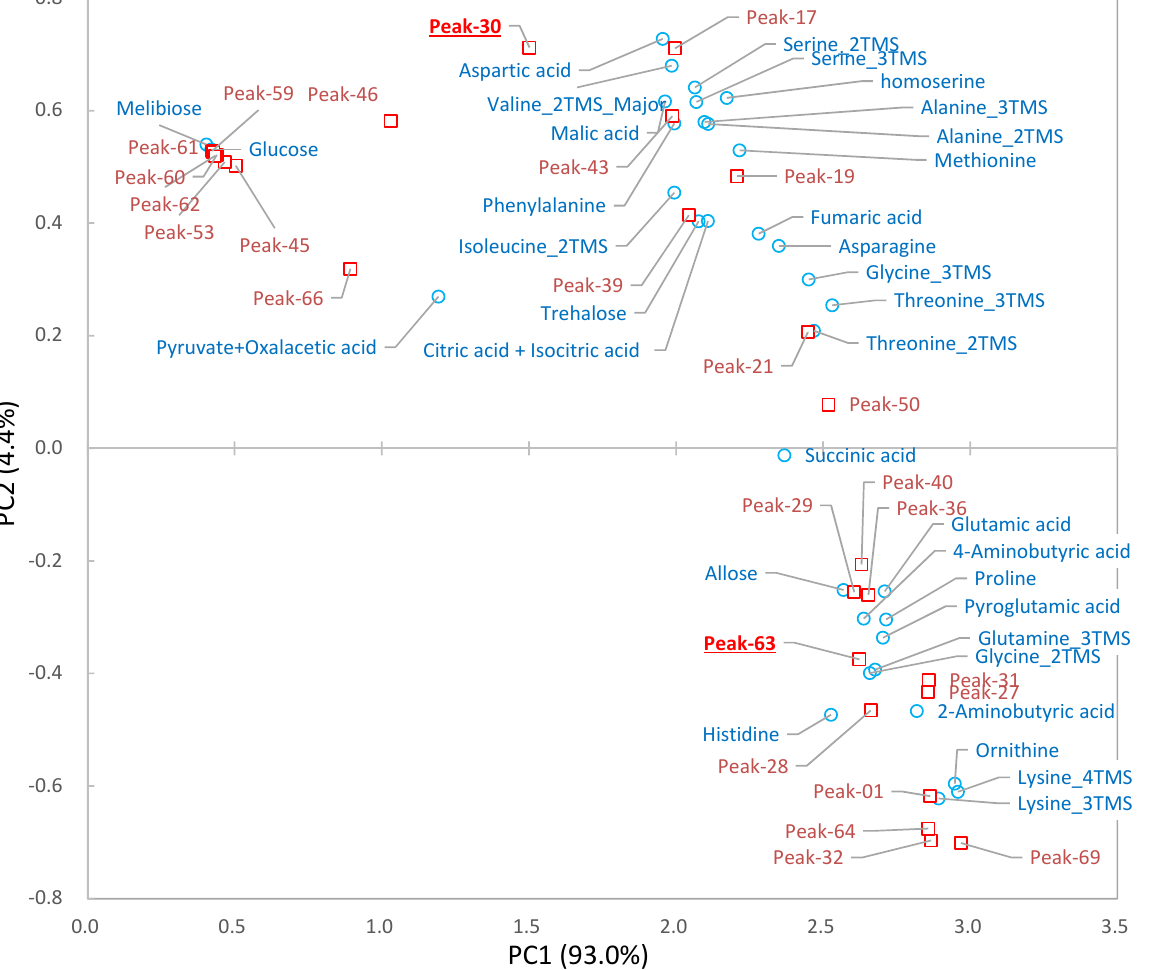
Figure 5. Score plot for principal component analysis (PCA) of metabolic turnover in S. cerevisiae X2180. The horizontal axis indicates principal component (PC) 1, and the vertical axis indicates PC 2. The values in parentheses are the percent variances of each PC. Open circles, and open squares indicate identified and unidentified peaks,